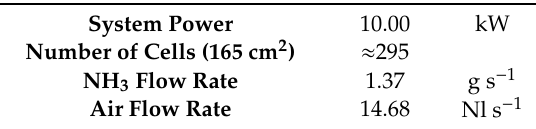
Table 6. Data of the 10 kW